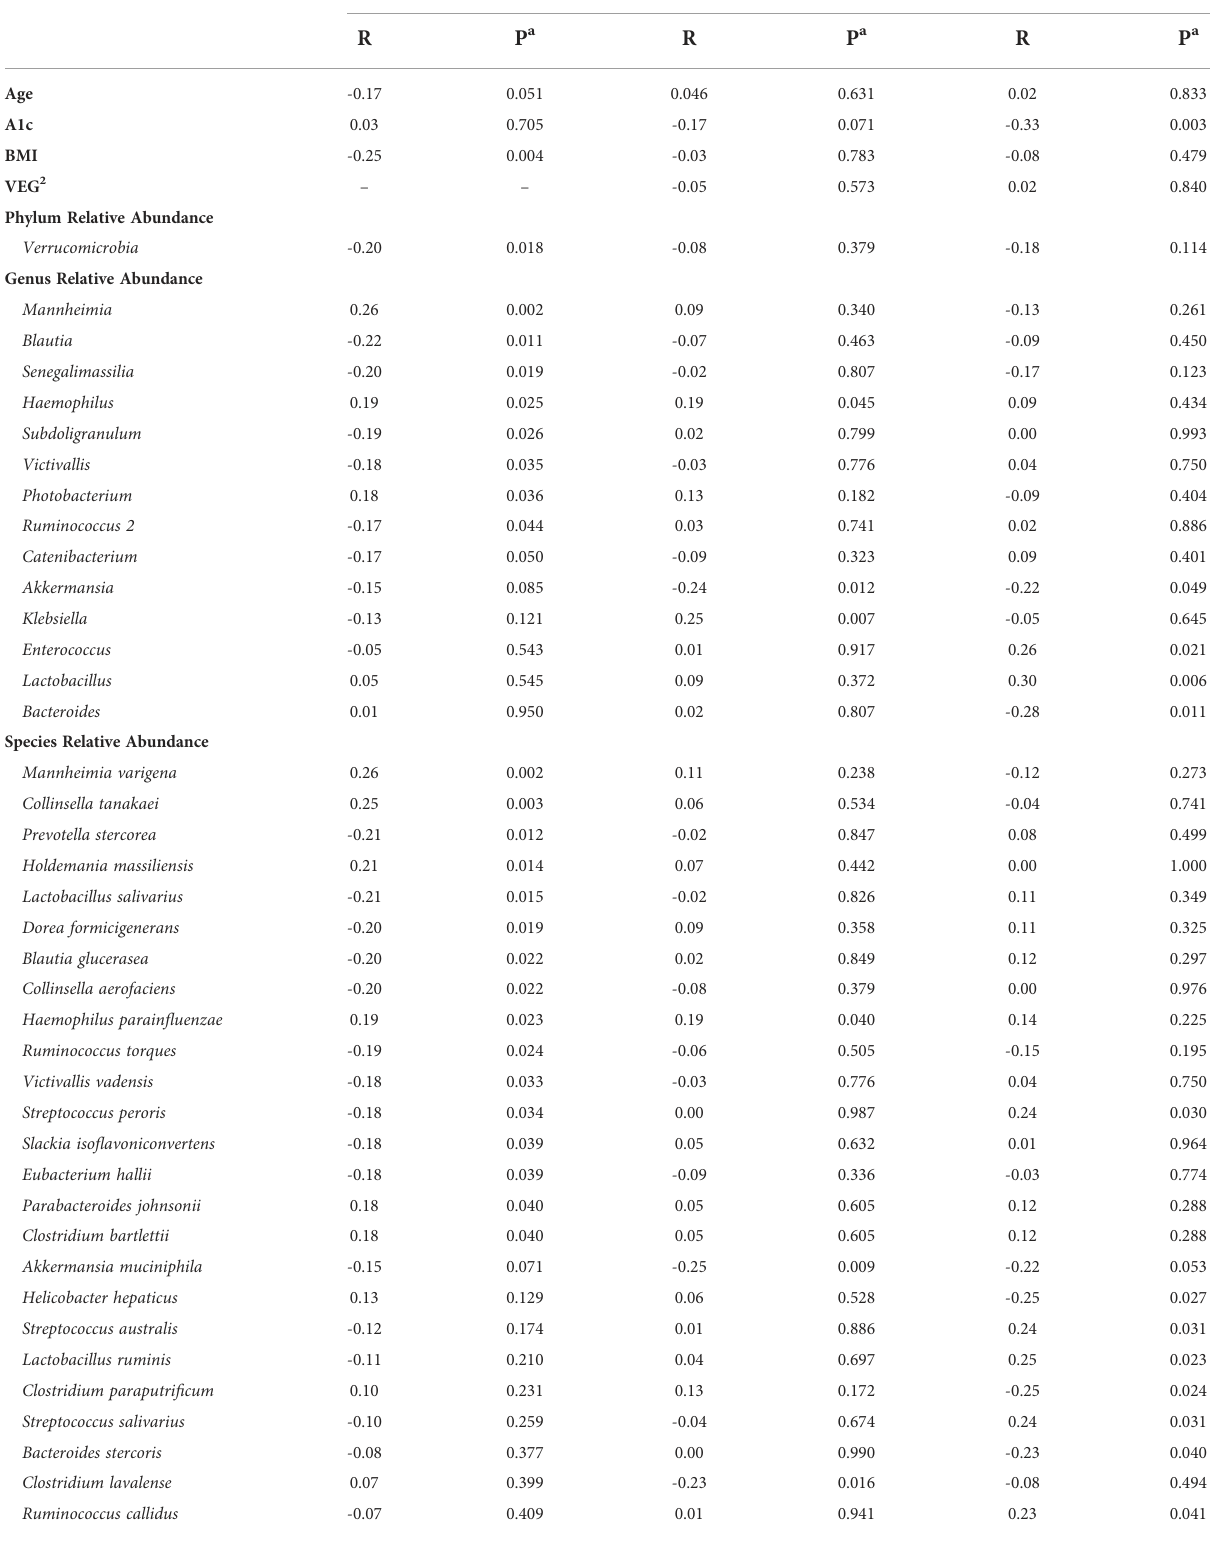
TABLE 3 Comparisons between biometrics, microbial abundances, VEG 2 scores and BUK levels. VEG 2 BUK DNA BUK